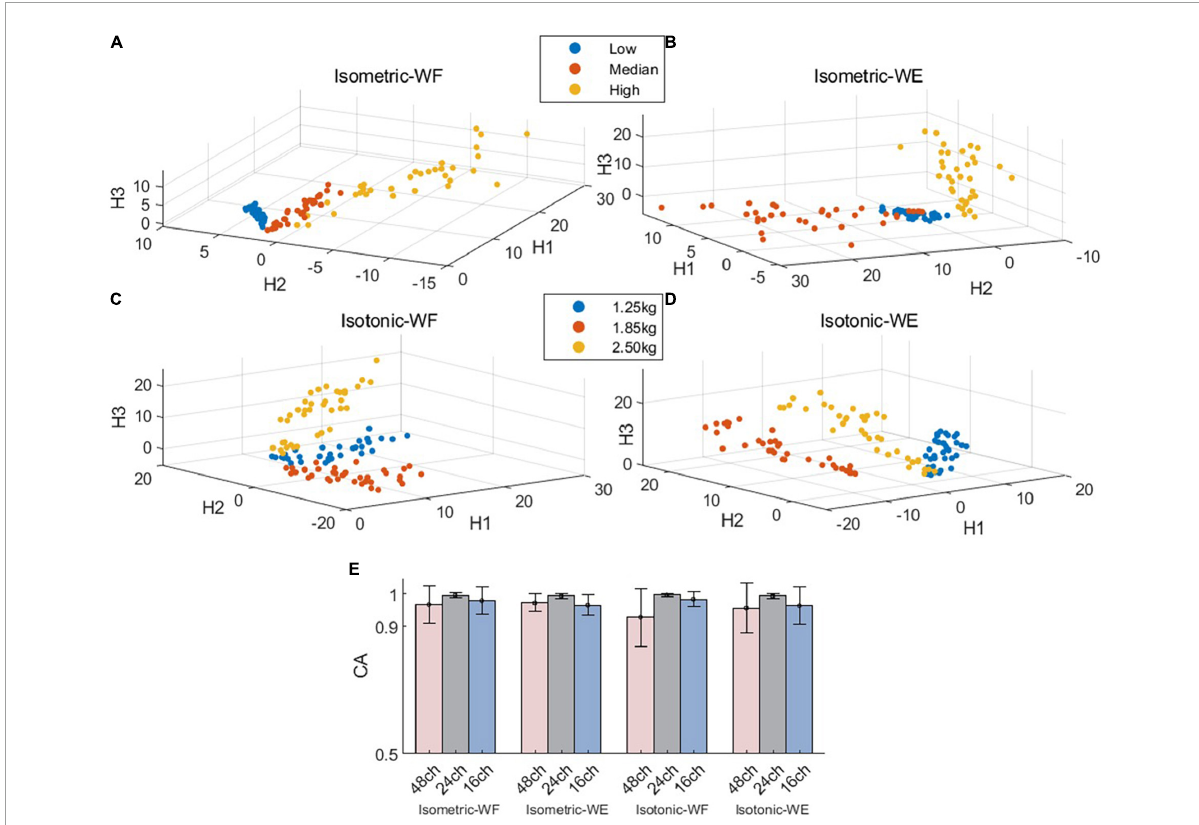
FIGURE4 Spatial distribution of the mean values of activation coefficients and overall discrimination performance. (A – D) Demonstrate the mean value scatter plot of two wrist movements for Subject 01 under two training modes. (E) Classification accuracies for isometric WF, isometric WE, isotonic WF, and isotonic WE. Three different electrode configurations denoted as 48ch, 24ch, and 16ch were considered,